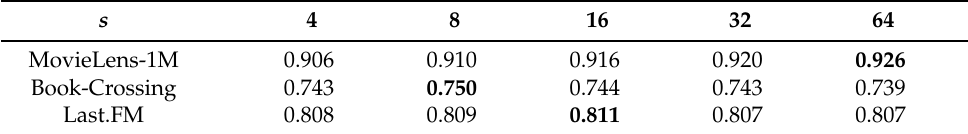
Table 7. Results of AUC on three datasets with different user’s initial entity